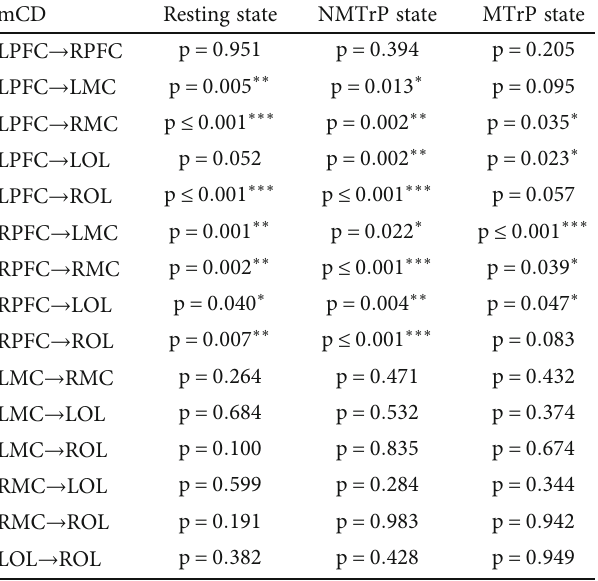
Table 3: Statistical results of mCDs among six brain regions in Interval V. mCD Resting state NMTrP state MTrP